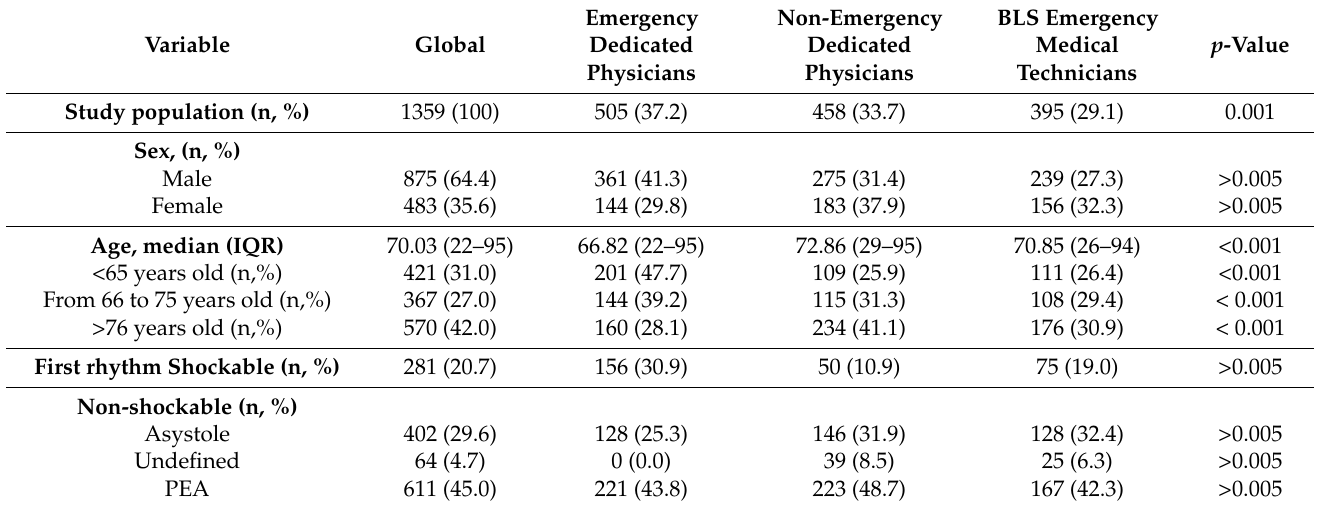
Table 1. Total attended